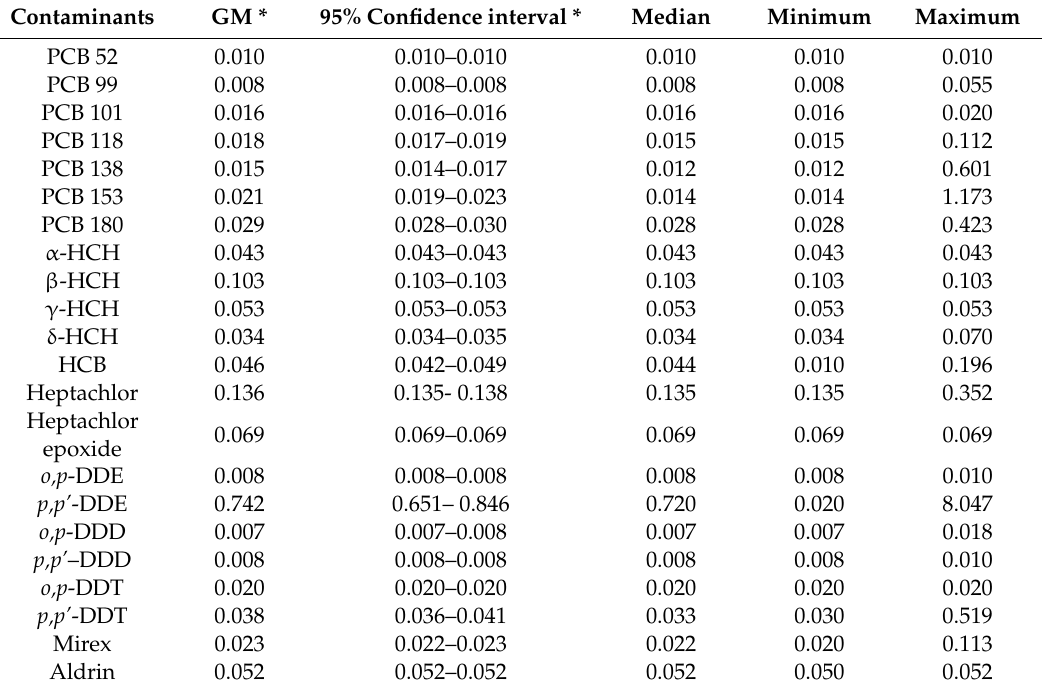
Table 2. Blood levels (wet weight picogram / microliter) of polychlorinated biphenyls (PCBs), hexachloro cyclohexane (HCH) and organochlorine pesticides (OCPs) in the study population (n = 194).